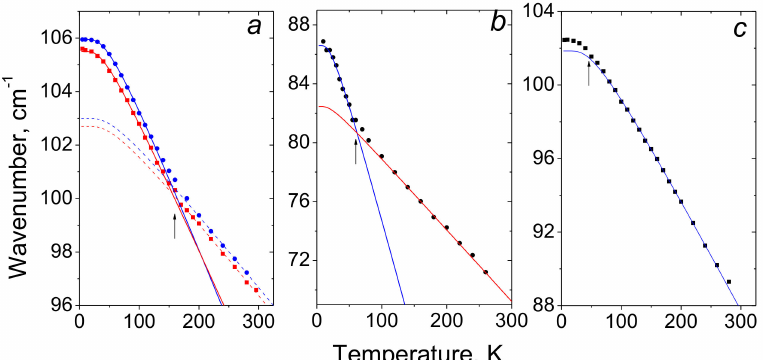
Figure 28. ω τ as function of temperature in symmetric TPA(H) (filled circles) and TPA(D) (filled squares) ( a ), quasisymmetric BZ ( b ), and asymmetric IB ( c ) tautomeric bonds. Solid curves are plotted from the anharmonic shifts of the phonon ω determined by its thermal population [48]. The arrow marks the position of the breakpoint of ω τ ( T